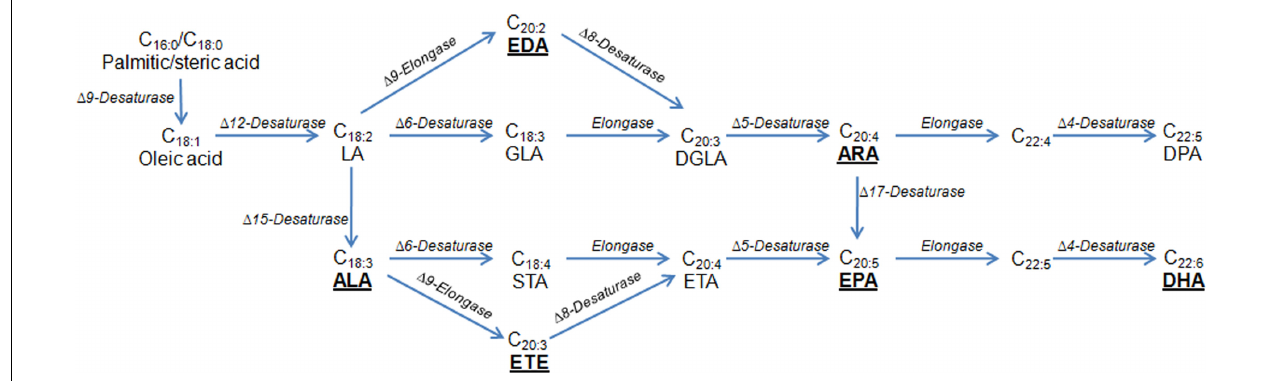
FIGURE 2 | Biosynthetic pathways for the production of PUFAs. Underlined are PUFAs produced by oleaginous yeasts. The pathway can be classified into a (cid:49) 6-desaturase pathway or a (cid:49) 9-elongase and (cid:49) 8-desaturase pathways (the (cid:49) 9 pathway). In the (cid:49) 6 pathway, the first step is the (cid:49) 6 desaturase to covert the LA and/or ALA to GLA and/or STA; the second step is the C18/20 elongase to convert the GLA and/or STA to DGLA and/or ETA. In the (cid:49) 9 pathway, the first step is the (cid:49) 9 elongase to convert LA and/or ALA to EDA and/or ETE; the second step is the (cid:49) 8 desaturase to convert EDA and/or ETE to DGLA and/or ETA. The last two steps are the same between these two pathways. ALA, α -linolenic acid; ARA, arachidonic acid; DGLA, dihomo- γ -linolenic acid; DHA, docosahexaenoic acid; DPA, docosapentaenoic acid; EDA, eicosadienoic acid; EPA, ω -3 eicosapentaenoic acid; ETA, eicosatetraenoic acid; ETE, eicosatrienoic acid; GLA, γ -linolenic acid; STA, stearidonic acid; LA, linoleic